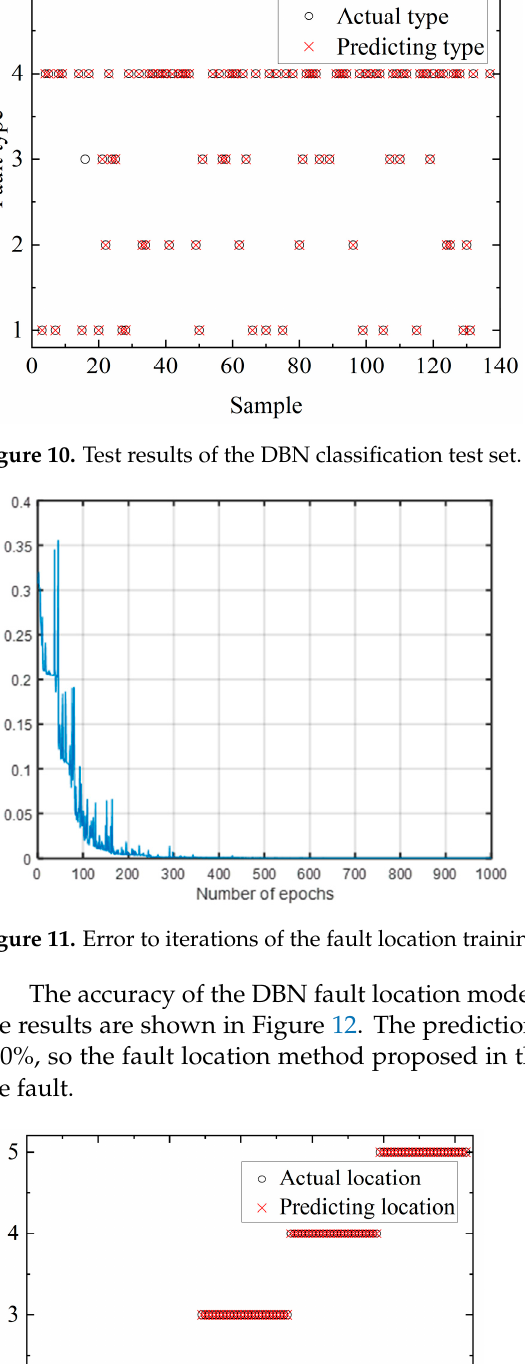
Figure 10. Test results of the DBN classification test set.